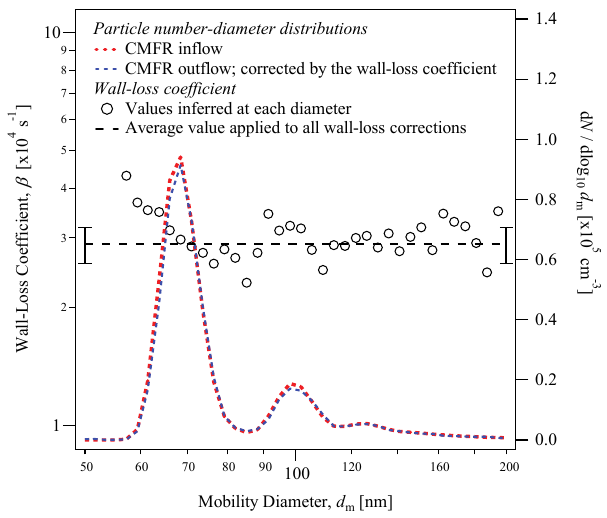
Fig. 1. Measurement of particle wall-loss coefficients β (s − 1 ) in the Harvard Environmental Chamber. Data are shown for one experi- ment using a population of dry ammonium sulfate particles. Points show the wall-loss coefficient inferred at each diameter such that the outflow number-diameter distribution matches the inflow dis- tribution. No trend with particle diameter is apparent. Therefore, wall losses are accurately represented by an average value, shown by the dotted line, for the investigated particle population. The er- ror bars represent one-sigma standard deviation of three replicate experiments.